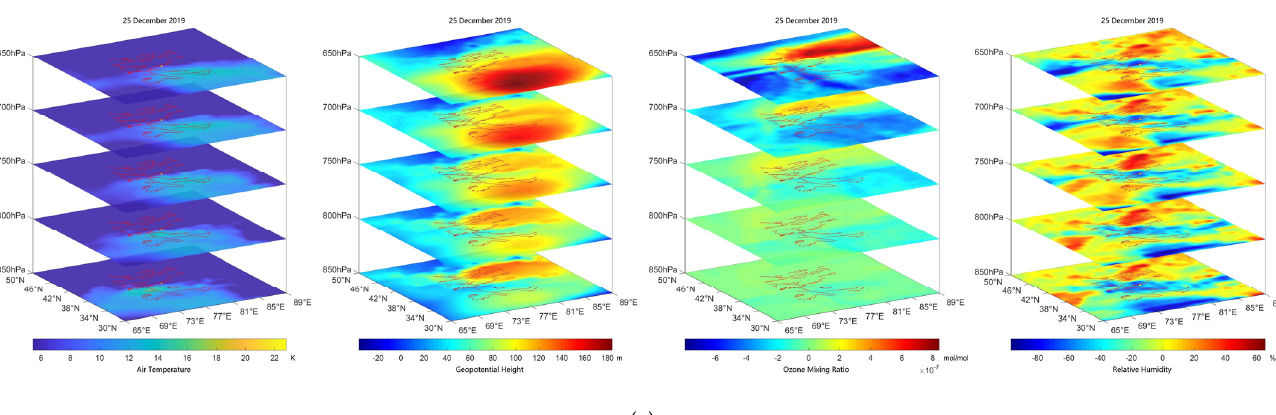
Figure A3. Composite atmospheric anomaly maps during atmospheric thermal anomalies associated with earthquake in Nima on ( a ) 8 June; ( b ) 9 June; ( c ) 10 June; ( d ) 11 June; ( e ) 12 June; ( f ) 13 June; ( g ) 14 June; ( h ) 15 June; ( i ) 16 June; ( j ) 17 June; ( k ) 18 June; ( l ) 19 June, 2020. The epicenter and faults are shown by yellow point and red lines, respectively. For each row, the subplots represent air temperature, geopotential height, ozone mixing ratio and relative humidity from left to right.